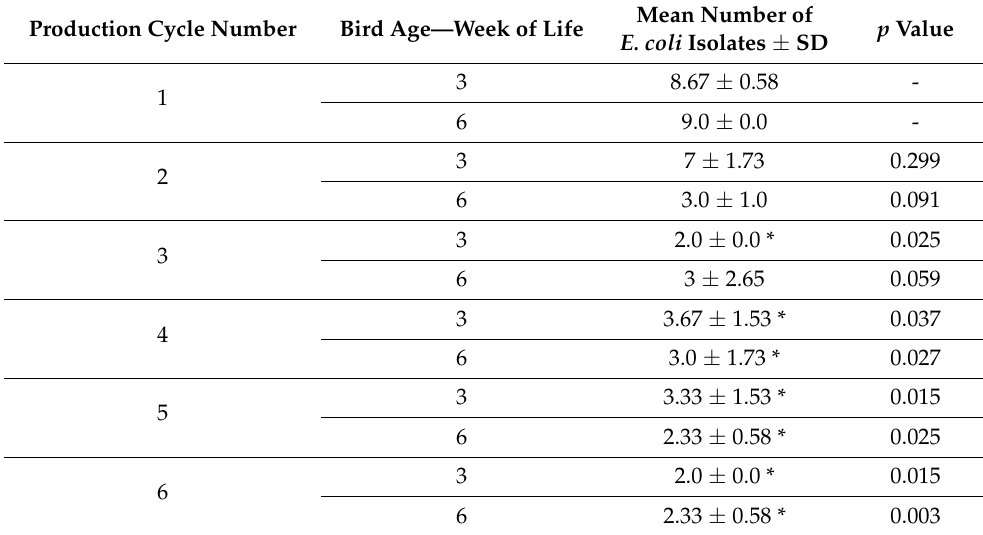
Table 1. Summarized results of E. coli isolation from experiment 1 bird samples. Production Cycle Number Bird Age—Week of